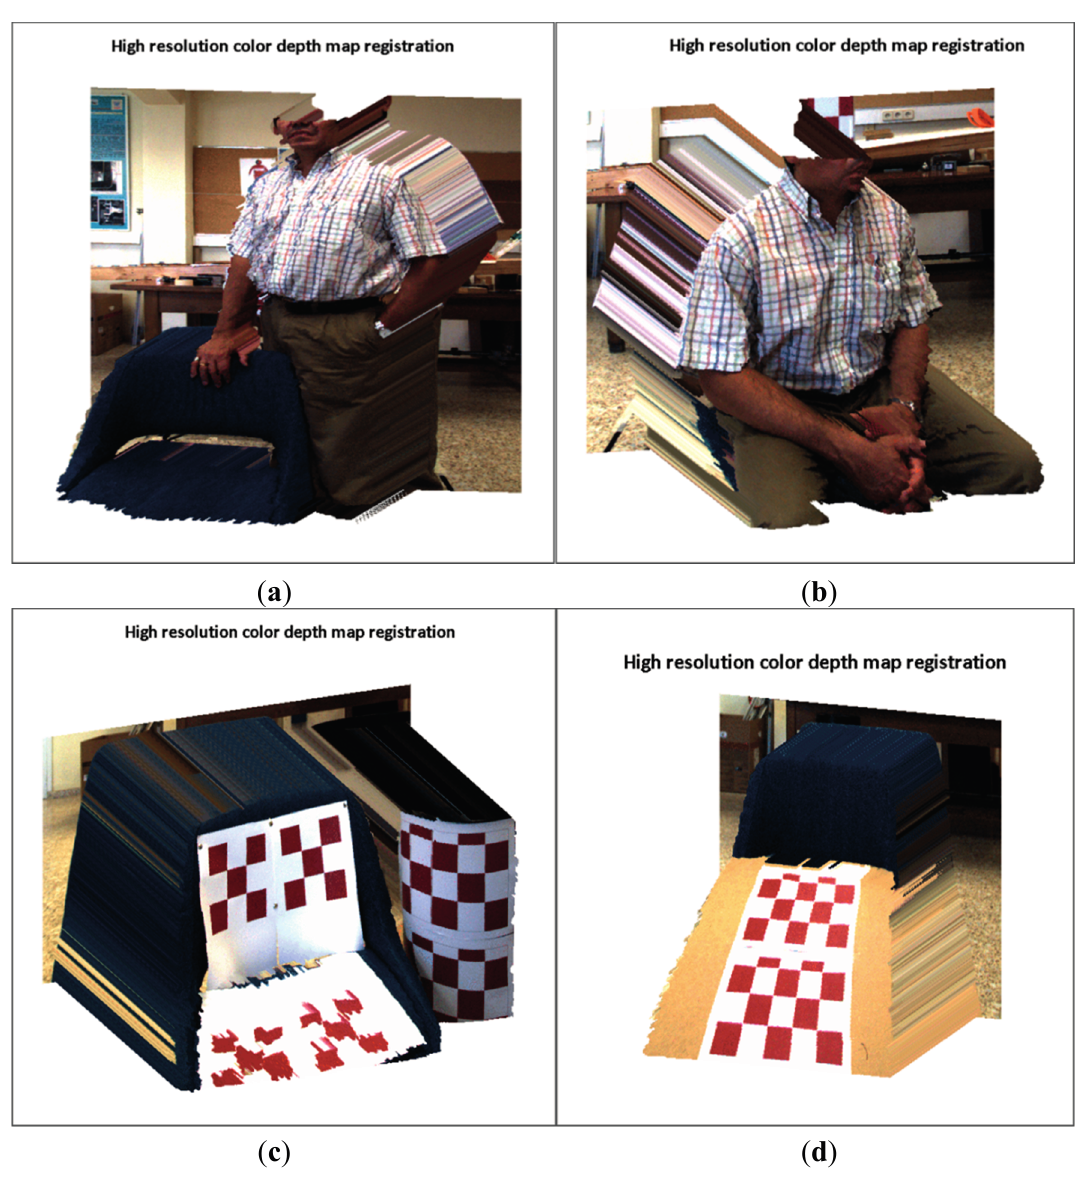
Figure 17. High resolution colour depth map reconstruction. ( a ) two volumetric objects placed at different distances from the sensory system; ( b ) an object with a large relief; ( c ) two curved objects; ( d ) a continuous surface which is slanted with respect to the cameras